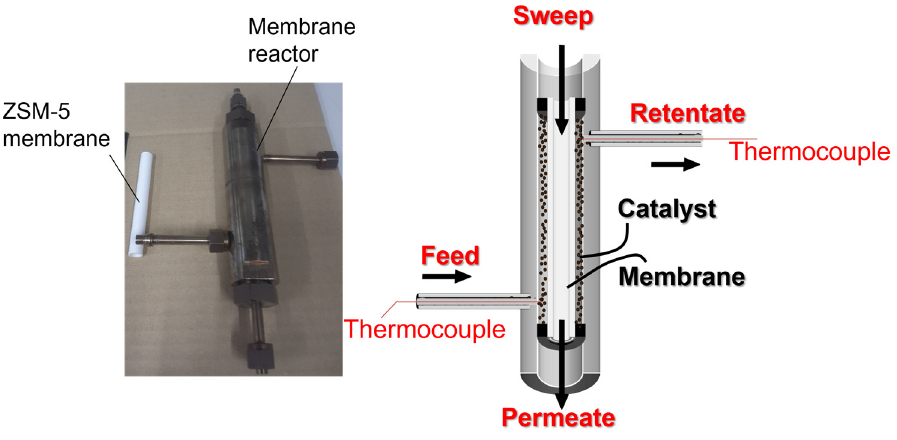
Figure 2. Picture and schematic diagram of membrane reactor.